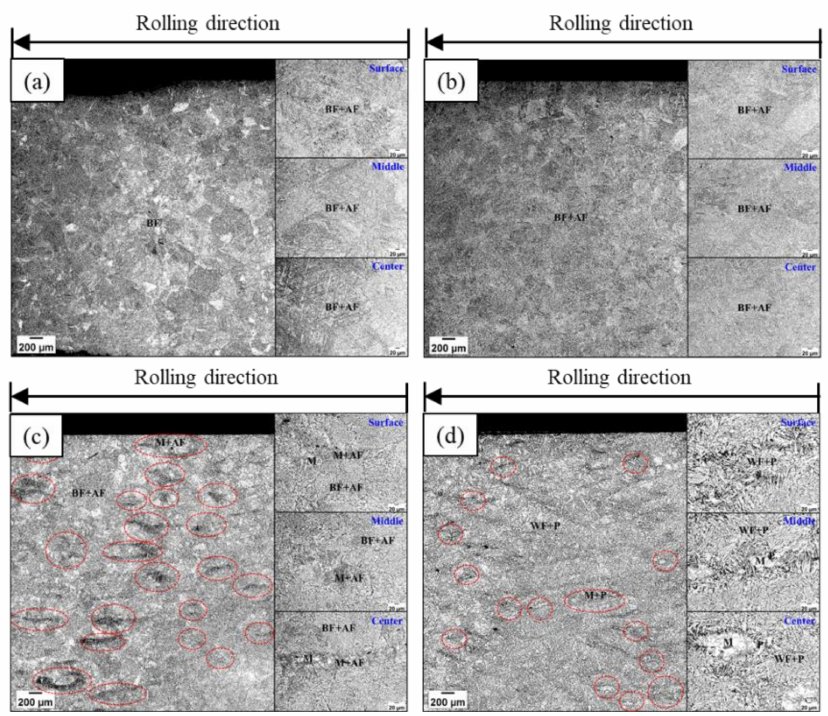
Figure 4. Microstructures of medium-carbon low-alloy steel isothermally heat treated for 240 min: hot-rolled steel heat treated at ( a ) 350 ◦ C, ( b ) 400 ◦ C, ( c ) 450 ◦ C, and ( d ) 500 ◦